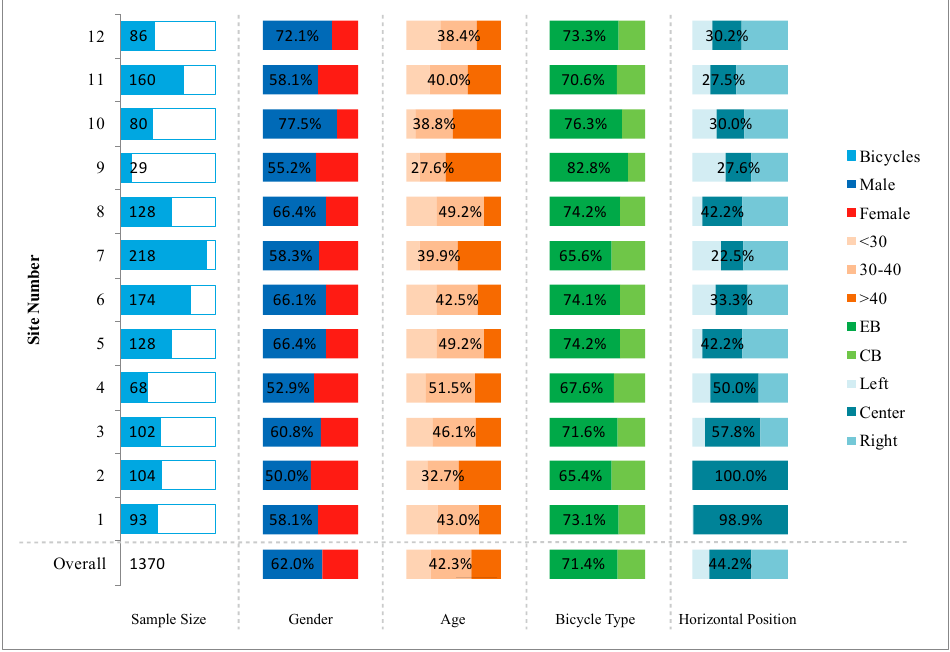
Figure 3. Statistical Description of Field Survey Data.